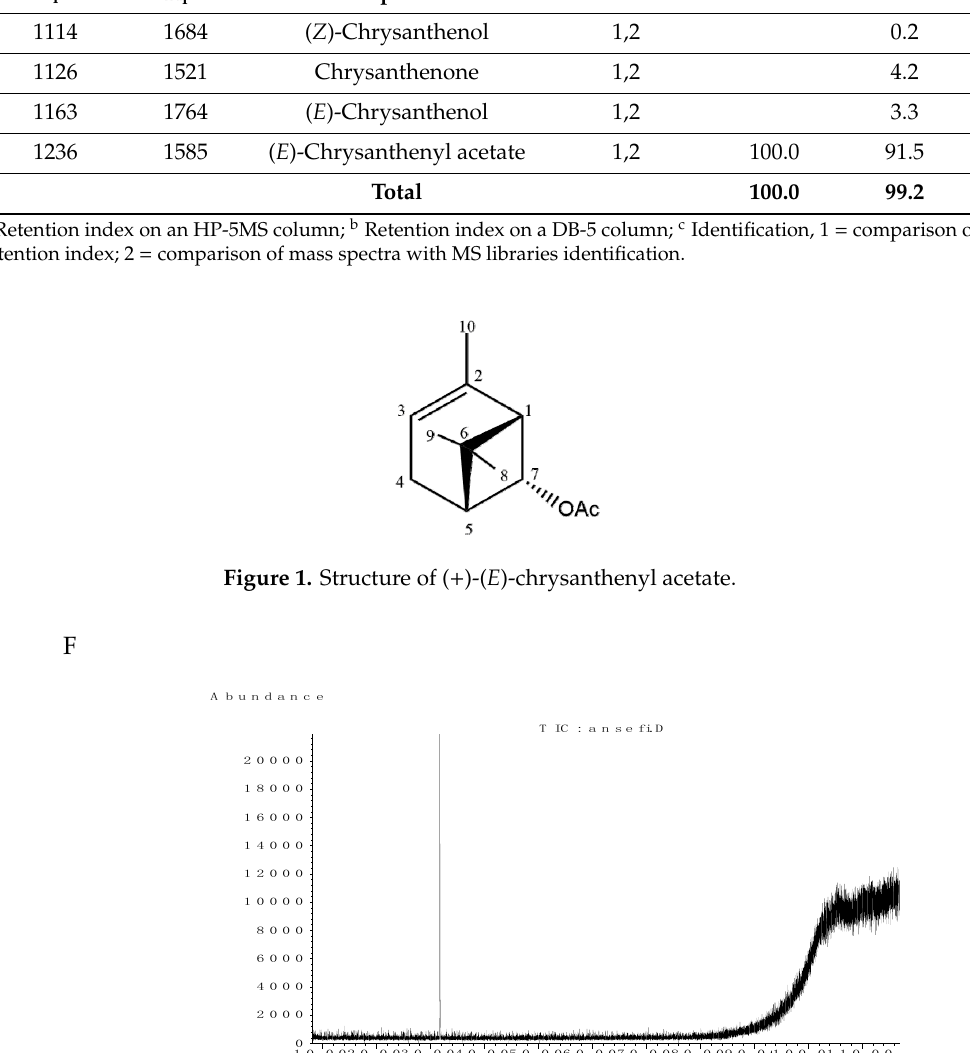
Table 1. Composition of essential oils from A. secundiramea Biv. ssp. secundiramea (Asteraceae).